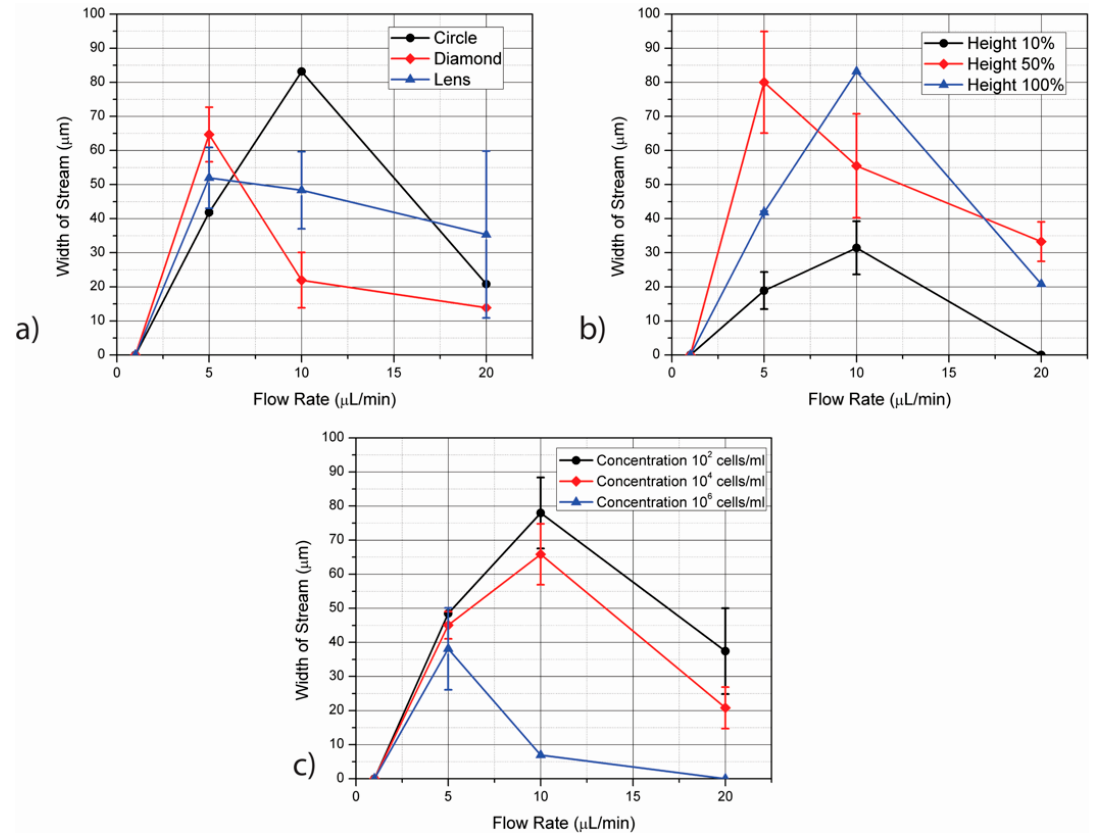
Figure 5. ( a ) The width of stream or zone obtained in the case of each electrode such that >98% pure streams of SC27 can be retrieved in the zone. The width of the zone initially increases with the increase in flow rate until it reaches a peak value before it starts decreasing. The circle shape features the widest zone for the flow rate of 10 µL/min followed by the lens and the diamond shape. However, the width of the zone decreases rapidly as the flow rate increases; ( b ) The width of the streams for obtaining >98% pure SC27 streams at different heights of the cylindrical electrodes as the flow rate varies. The stream width for the case of heights 50% and 100% of the channel are comparable as seen in this figure and are much higher than the case of height 10% of the channel. This reiterates the effect of height of the electrode for focusing. In this case, the stream width decreases with increase in flow rate; ( c ) The study of concentration of streams was conducted for stream purities of 98% and above with the increase in flow rates. The zone width increases with flow rate and shows a peak at the flow rate of 10 µL/min, after which it decreases. The zone width increases as the concentration of the cells decrease, mostly owing to less contamination of SC27 cells by SC23 cells that are retrieved through the zones.